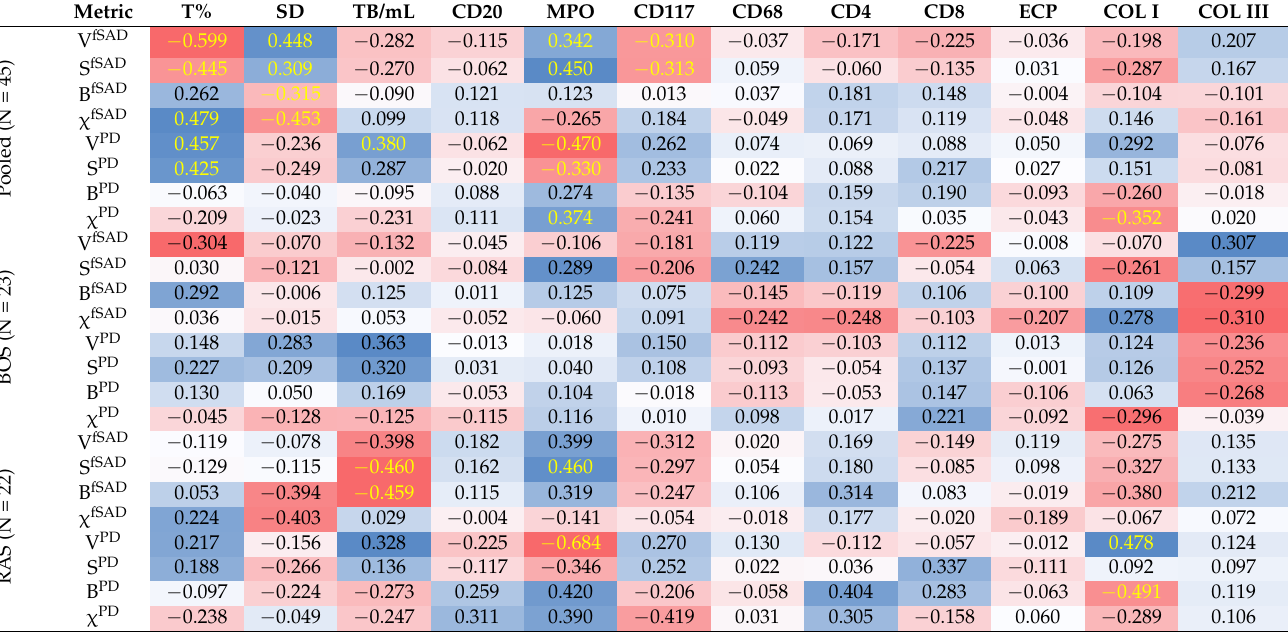
Table 4. Correlations of tPRM metrics of dominant subtypes to structural and biological